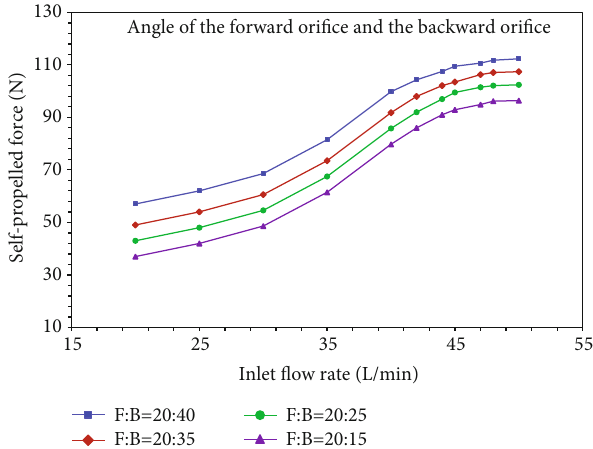
Figure 9: E ff ects of the inlet fl ow rate on the self-propelled force for representative values of F : B